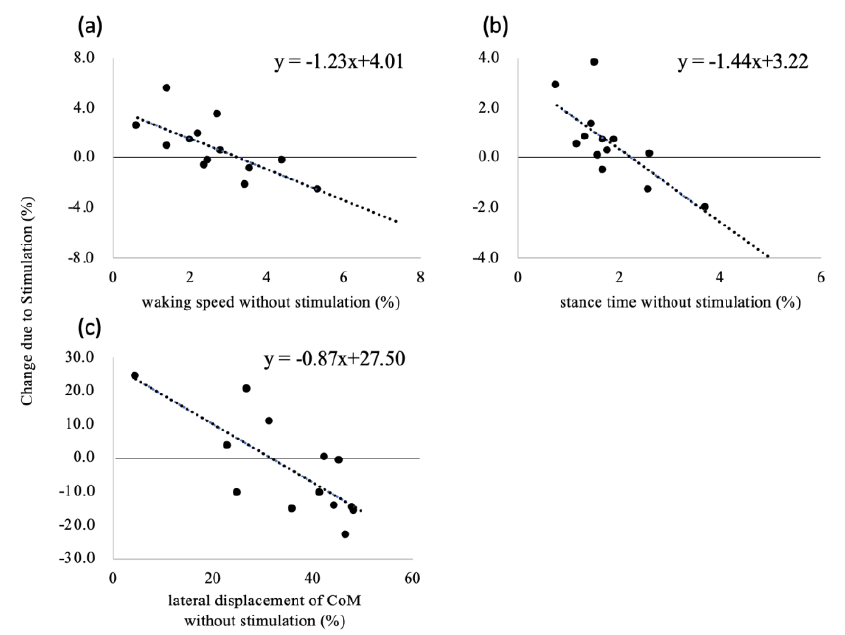
Figure 3. Relationship between the coefficient of variation (CV) without vibrotactile stimulation and changes due to stimulation for ( a ) walking speed, ( b ) stance time, and ( c ) center-of-mass (CoM) movement in the lateral direction.